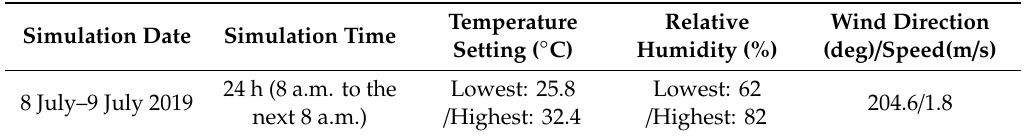
Table 3. Input boundary